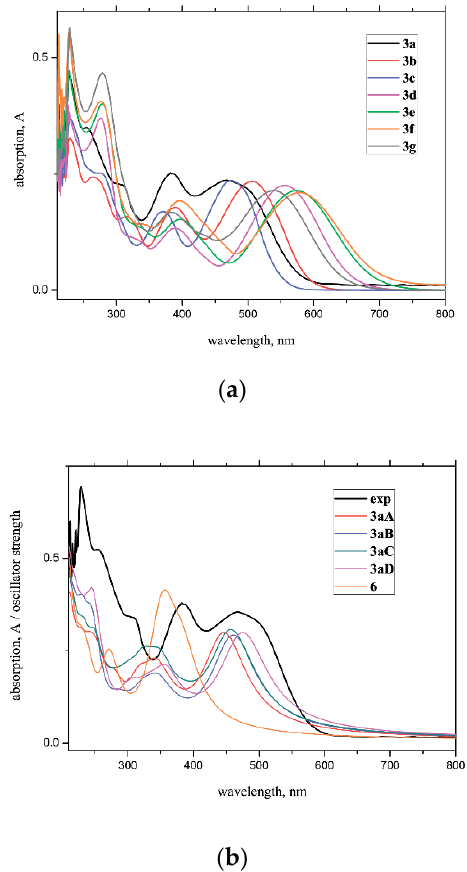
Figure 6. ( a ) Experimental UV/Vis spectra of 3a – 3g , in CH 2 Cl 2 ; ( b ) experimental UV/Vis spectrum of 3a and quantum-chemically simulated spectra of 3aA – 3aD and 6 .